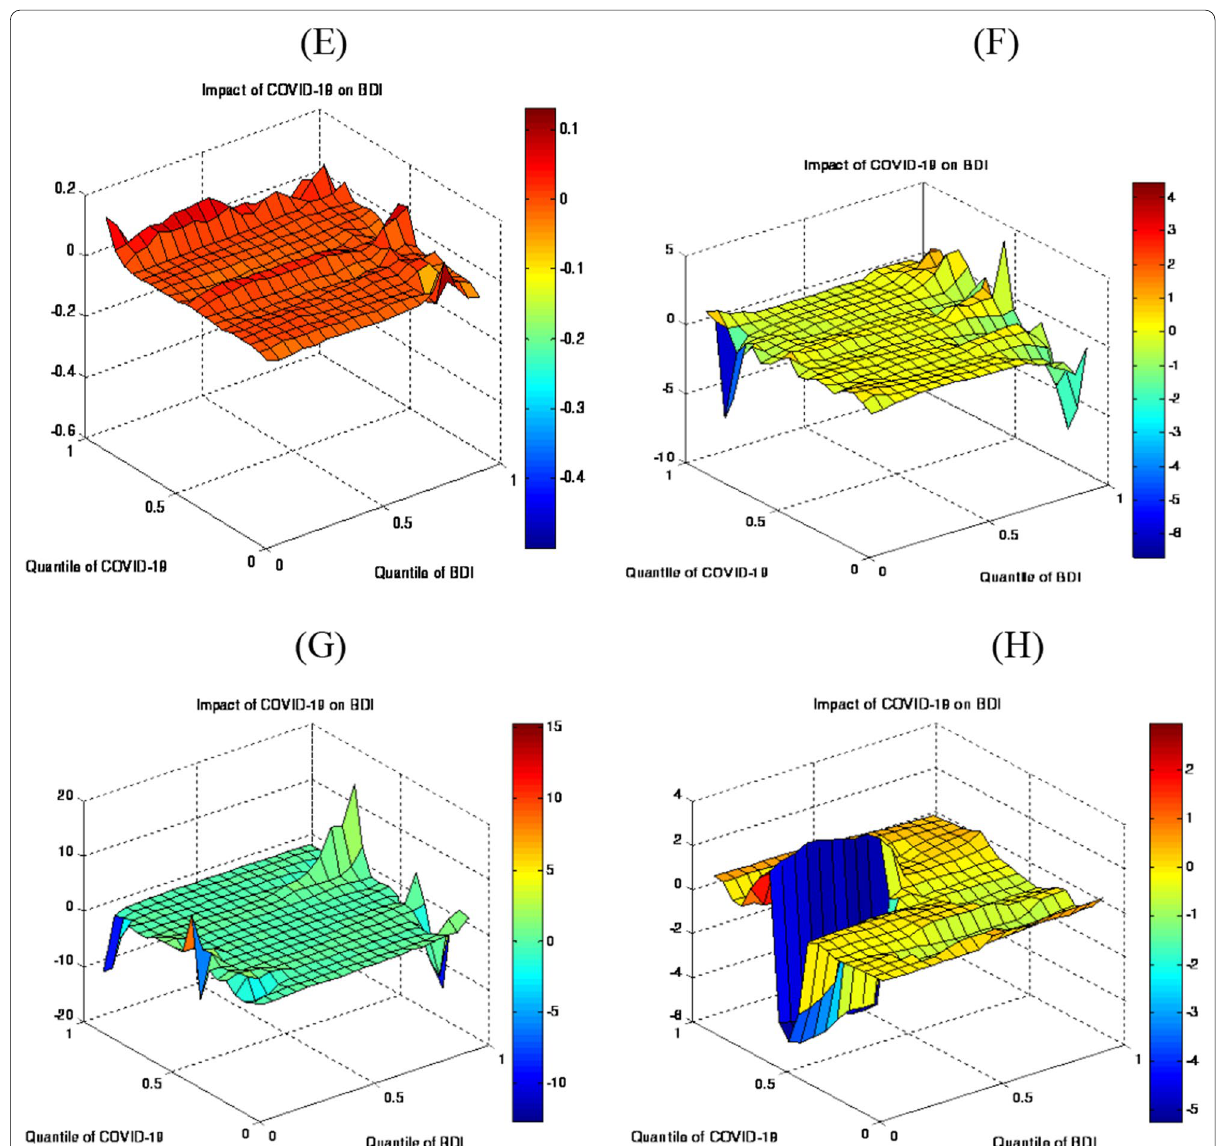
Fig. 3 Slope coefficient of QQ